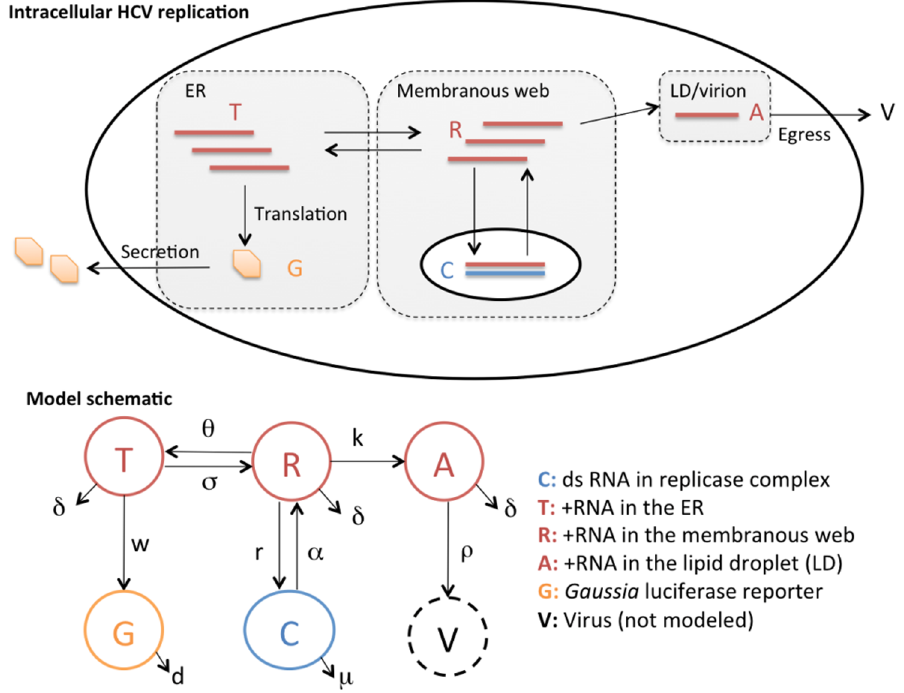
Fig 6. Schematics for intracellular HCV replication dynamics considered in this study and the corresponding mathematical model. We considerthe dynamicsof positive strand HCV RNAs (+RNAs) in the ER (T), in the membranous web (R) and in the lipid droplets(A), the replicasecomplex (C) and the extracellular Gaussia luciferase (GLuc) proteins (G). See text for detailed explanations.